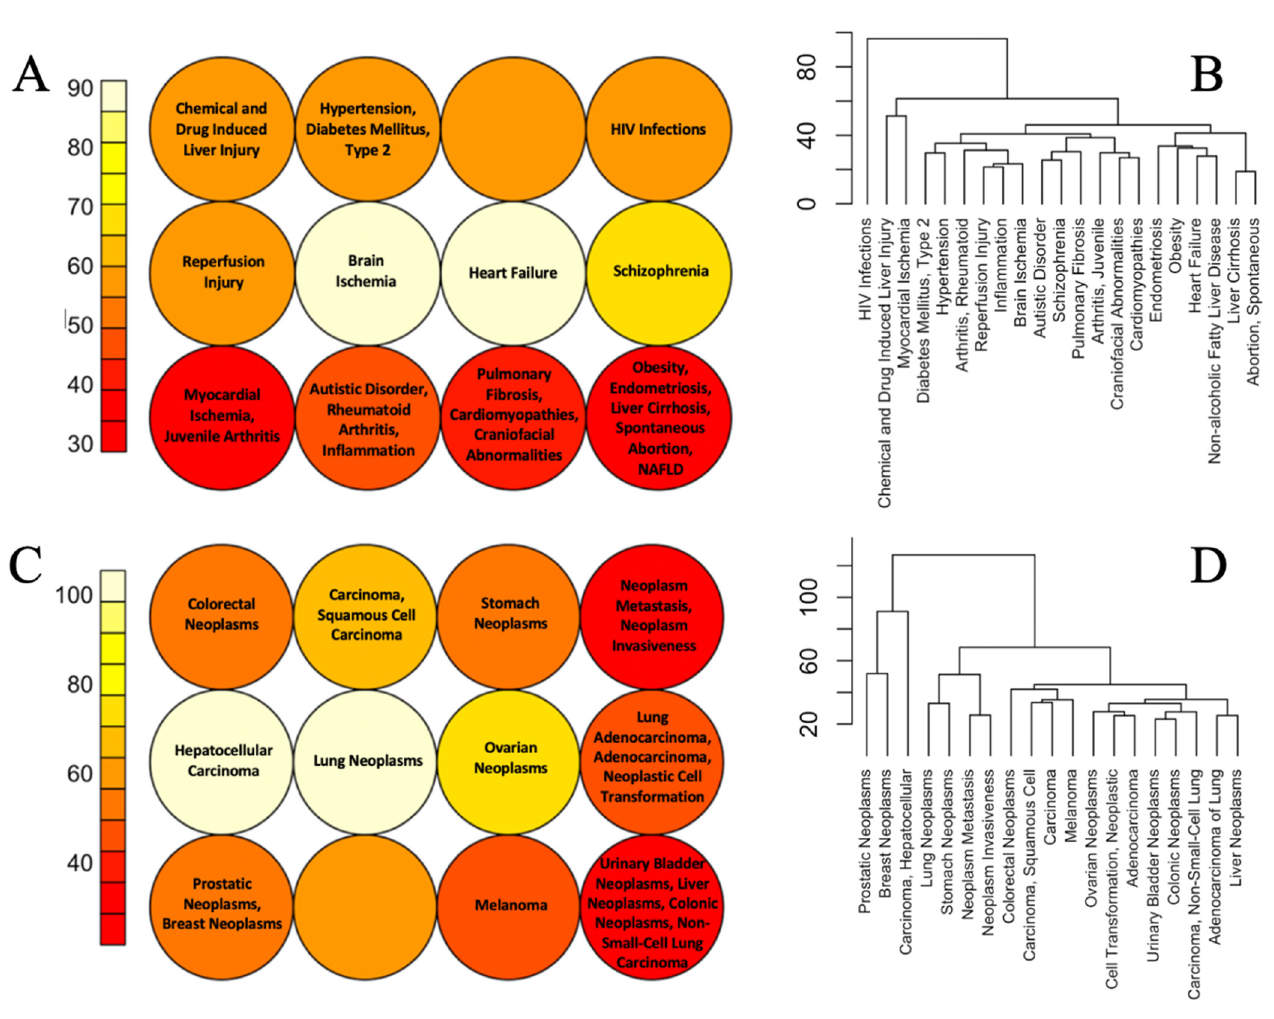
Figure 3. SOM neighbor distant plots ( A , C ) and hierarchical clustering ( B , D ) of non-neoplastic ( A , B ) and neoplastic ( C , D ) diseases based on the similarity of their overlap with chemically sensitive Reactome pathways. In SOM plots, cells of similar color contain related diseases.